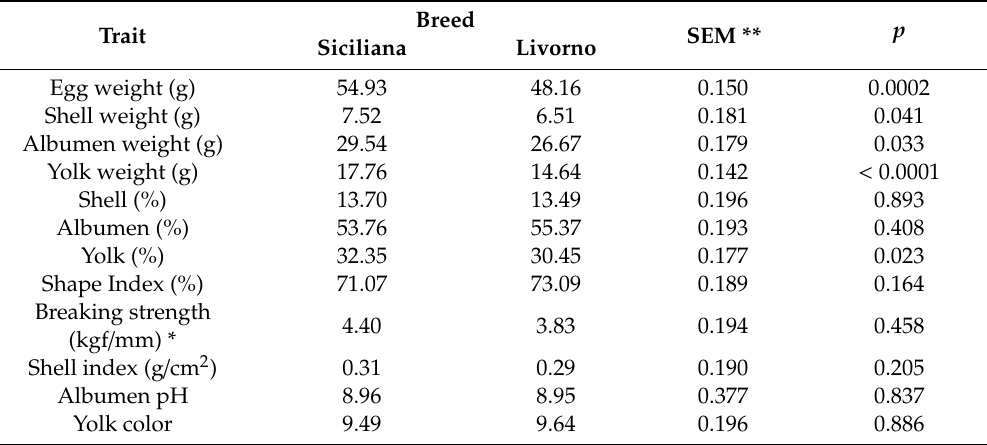
Table 2. E ff ect of genetic type on physical characteristics of